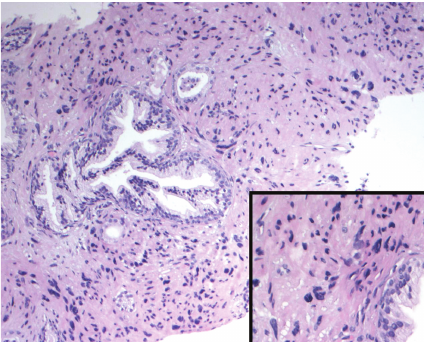
Figure 1: H/E stain, low-power magnification (10x) with high- power inset (20x) prostatic tissue showing hypercellular stroma with atypical hyperchromatic nuclei surrounding benign prostatic glands present focally in one of ten needle biopsies. Inset shows a higher power view of the atypical stromal cells with smudgy chromatin and adjacent normal prostatic acinus in lower